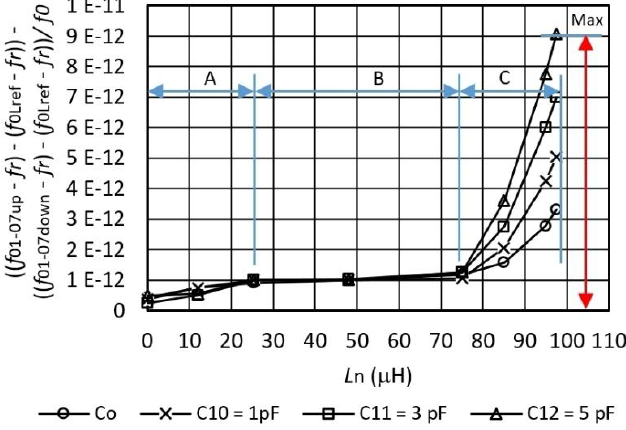
Figure 6. Characteristics f 0 − f r , f 01-07 − f r (depending on L n ) and f 0Lref − f r = 5 kHz acquired with the alternate multiplexer switching at different capacitances C 10-12 = 1, 3, and 5 pF at T = 25 °C).